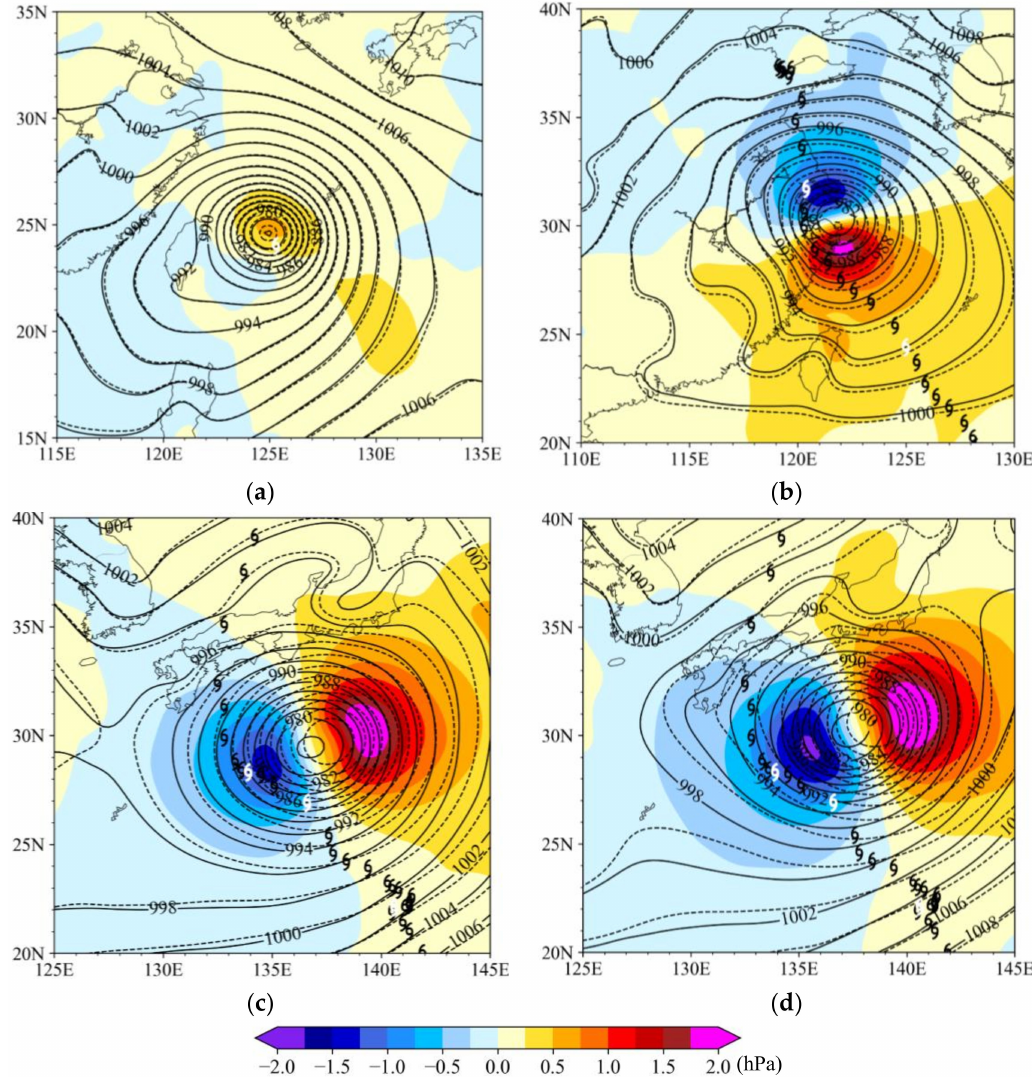
Figure 7. Spatial distribution of the forecasted SLP of ODS (solid contours at 2-hPa interval) and CTRL (dashed contours at 2-hPa interval) and their di ff erences (ODS-CTRL, shaded) at ( a ) 1200 UTC 8 August 2019 (3-h forecast), ( b ) 1800 UTC 10 August 2019 (57-h forecast), ( c ) 1800 UTC 12 August 2019 (105-h forecast) and ( d ) 1200 UTC 13 August 2019 (123-h forecast). The locations of the observed centers of ( a , b ) Lekima and ( c , d ) Rosa are indicated by typhoon markers; the white typhoon markers represent the central positions at that particular time. Forecasts of the geopotential height at 500 hPa were further evaluated by comparison with the final analysis (FNL) data [46]. Figure 8 shows the mean bias (solid curves) and standard deviation (dashed curves) of the di ff erence between the forecasts and the FNL data (FNL − CTRL, FNL − ODS) with the forecast time for the geopotential height at 500 hPa and the air temperature at 300 hPa. The blue curves represent the di ff erence between the ODS and the FNL data (FNL − ODS), whereas the black curves represent the di ff erences between the CTRL forecast and the FNL data (FNL − CRL). Figure 8a shows that with an increase in the forecast time, the mean bias remained slightly positive (about 2 gpm) for the first 110 h, but then quickly shifted to a negative bias as high as − 8 gpm, while the standard deviation gradually increased. The mean bias and the standard deviation of the two experiments were similar in the first 110 h, after which the bias and standard deviation of the ODS experiment were stable, but smaller, than in the CTRL